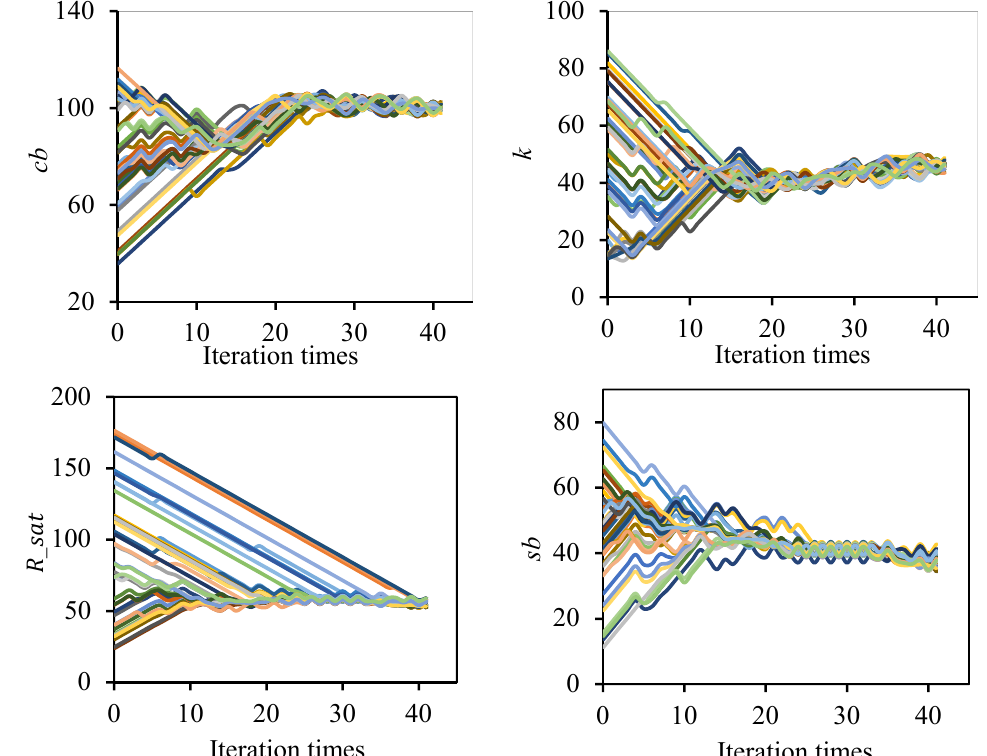
Figure 6. Parameter iteration: cb, k, R sat and sb . For optimization with VW-PSO, three different intervals (shown in Figure 4), de- scribed as tensile flow yield interval (interval I), instantaneous Bauschinger effect interval (interval II) and permanent softening interval (interval III), were separately selected to enhance accuracy, with the weight coefficient equal to 15. These intervals were selected because they are the key sections used to describe the deformation characteristics of ma- terials. The tensile flow yield interval, representing the plastic deformation and hardening with tension load, is important in the plastic forming process, as stamping and deep draw- ing predict the deformation state after formation. The instantaneous Bauschinger effect interval shows the plastic state entering compression load, and this could be employed to estimate the occurrence of plastic deformation when the retired part is reformed to its original shape. The permanent softening interval reflects the plastic deformation and hardening with compression load, which could be used to predict the deformation state after reforming with a reverse load. For optimization with standard PSO, various particle numbers, including 10, 20, 30 and 42, were tested in order to study the particle number ′ s influence on the optimization procedure and results. 3.2. Results The optimal parameters of standard PSO and OS-PSO are summarized in Table 2. While the graphical solution left a 13.09% residual error, indicating a large deviation be- tween the experiment and the simulation, both standard PSO and OS-PSO resulted in an improved residual error of around 4%. The genetic algorithm (GA) resulted in a compar- atively lower accuracy, with a residual error of 6.84%. Table 2. Optimal parameters with standard PSO and OS-PSO. Method